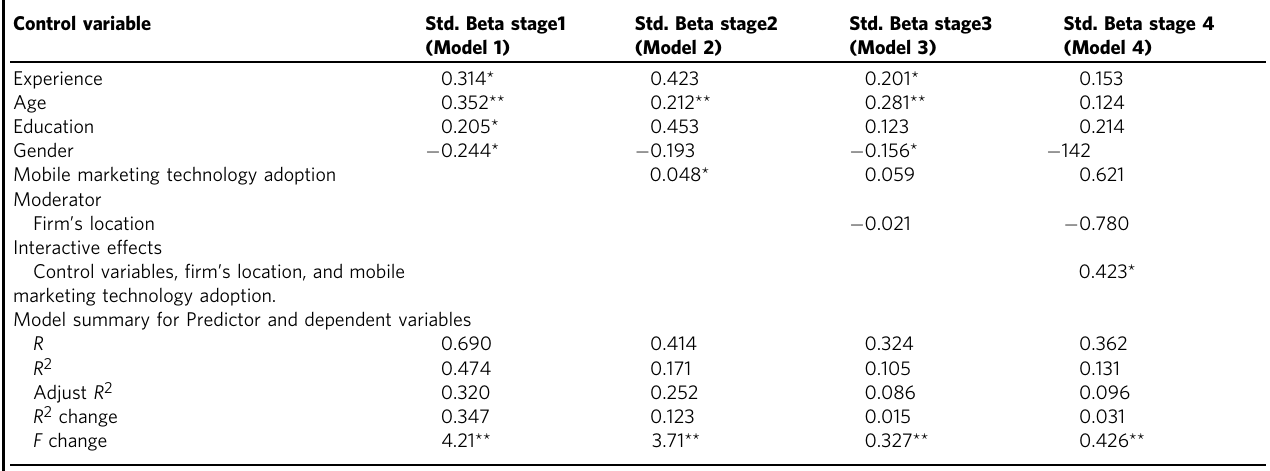
Table 3 Regression